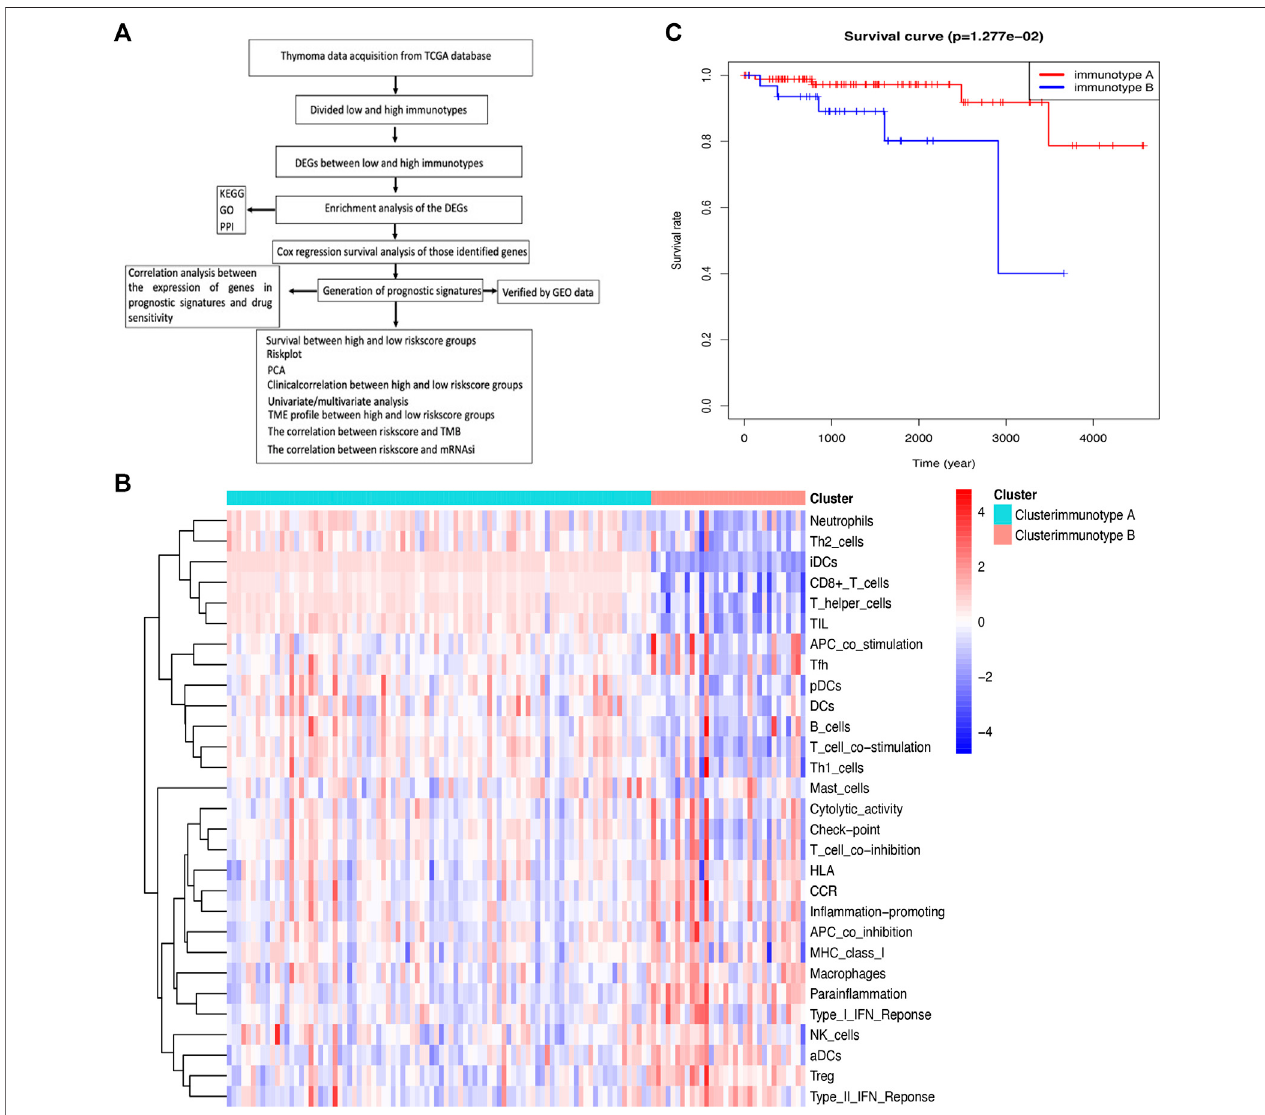
FIGURE1| Comparison ofimmune cellin fi ltration between immunotypes Aand Bin THYM. (A) Flow chartfor theidenti fi cation ofimmunesignatures inTHYM. (B) The heatmap shows that the THYM samples were classi fi ed as immunotype A or B according to immune cell in fi ltration. (C) Kaplan – Meier curves show that the immunotype A had greater mortality than the immunotype